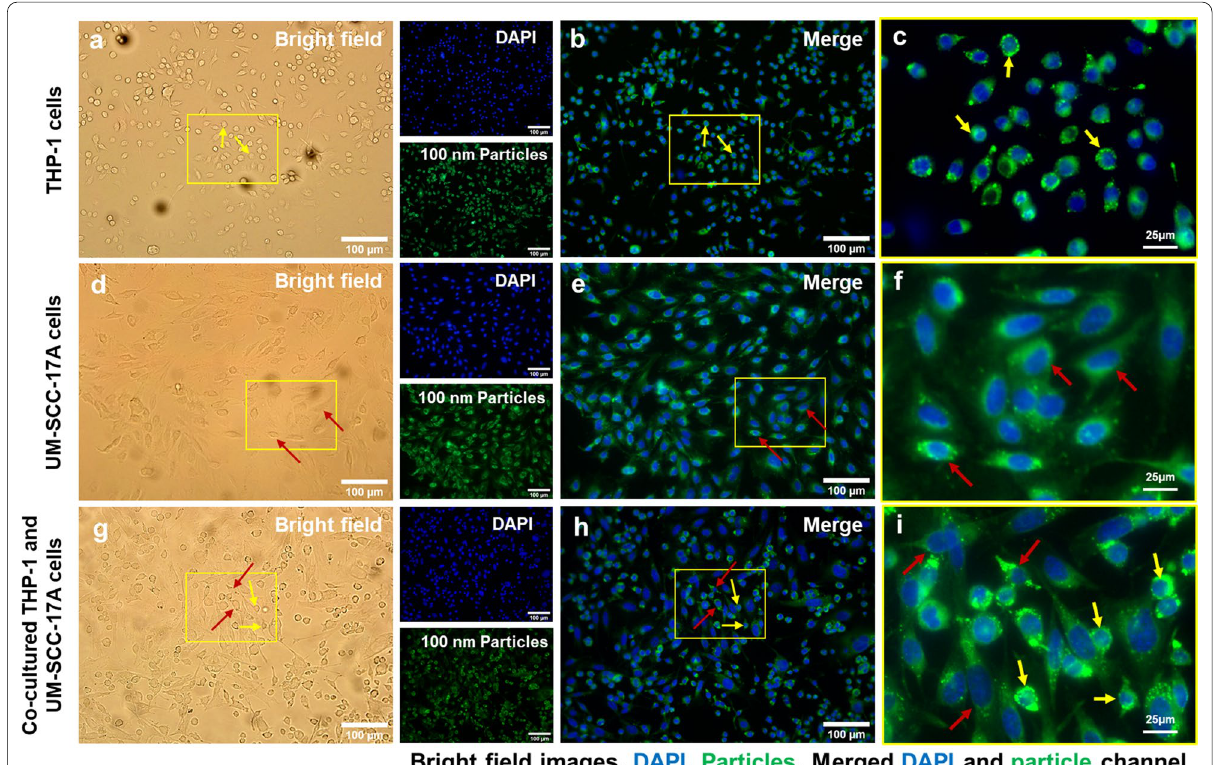
Fig. 4 Microscopic examination of cellular internalization of 100 nm PLGA nanoparticles in monoculture and co‑culture cells. Single type of cells or mixed cells was treated with 100 nm PLGA nanoparticles for 24 h at 37 °C at a concentration of 10 µg/mL. Cells were observed under bright‑field ( a , d , g ) and fluorescent channels (b, e, and h) with particles observed at the green channel and cell nuclei in the blue channel after stained with Hoechst. Massive cellular uptake of 100 nm PLGA nanoparticles can be visualized in magnified images ( c , f , i ) for monoculture THP‑1 macrophages (yellow arrows) and laryngeal cancer cells UM‑SCC‑17A (red arrows). In the co‑culture system, 100 nm PLGA nanoparticles were still highly ingested by macrophages but less efficient for cancer cells compared to single cultured